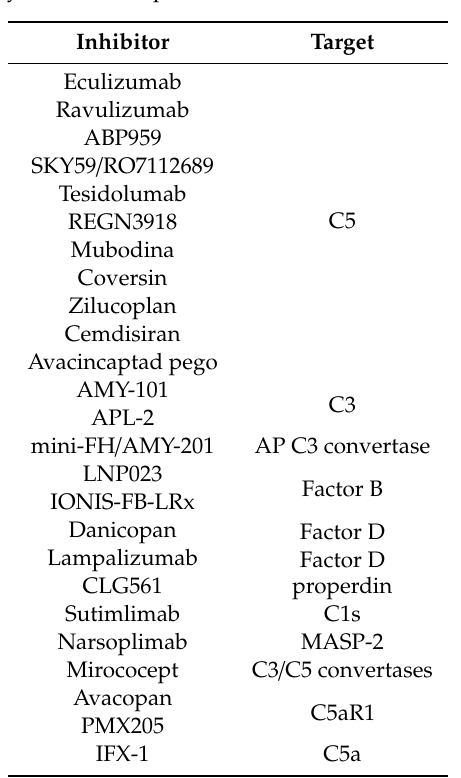
Table 1. Summary of novel complement inhibitors under clinical